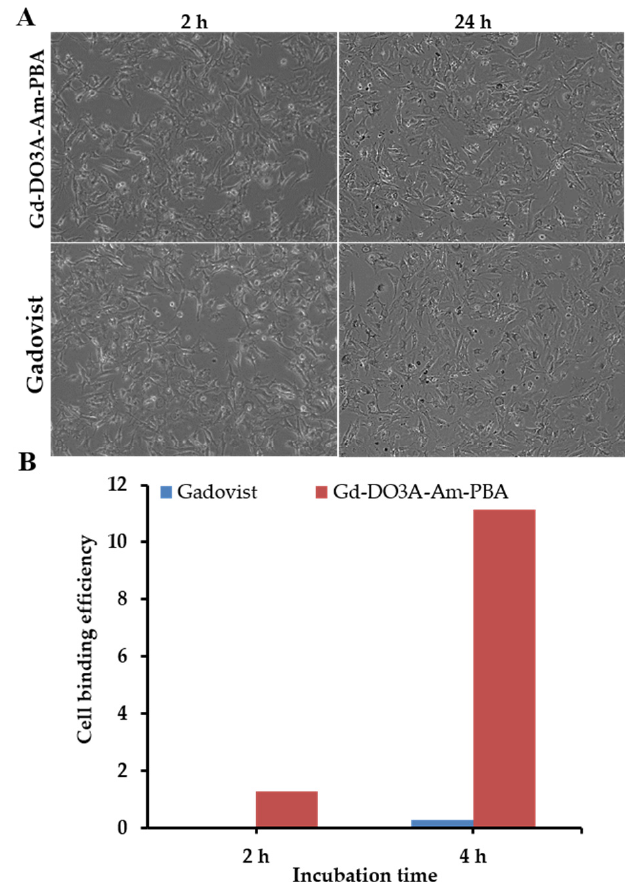
Figure 6. Effect of incubation time on cell labeling. ( A ) Phase-contrast micrographs of melanoma cells 2 h and 24 h after the addition of 0.5 mM Gd-DO3A-Am-PBA or Gadovist (10× magnification). ( B ) Comparison of binding efficiency of Gd-DO3A-Am-PBA or Gadovist after 2 h and 4 h of cell incubation.